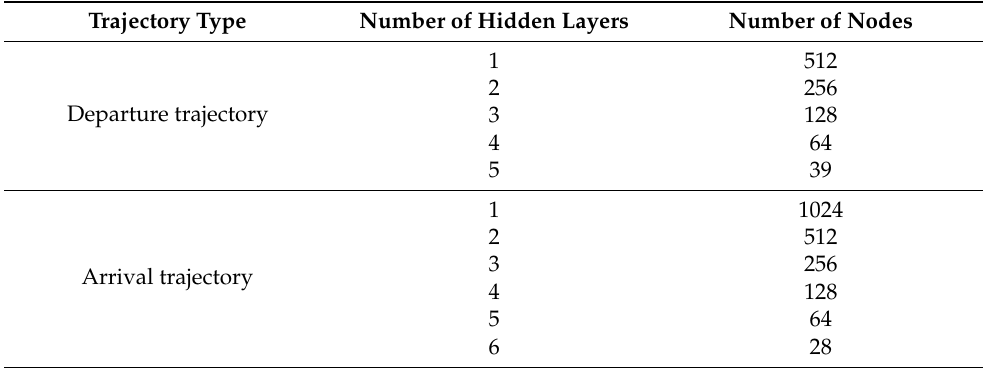
Table 1. Parameter settings for the model.